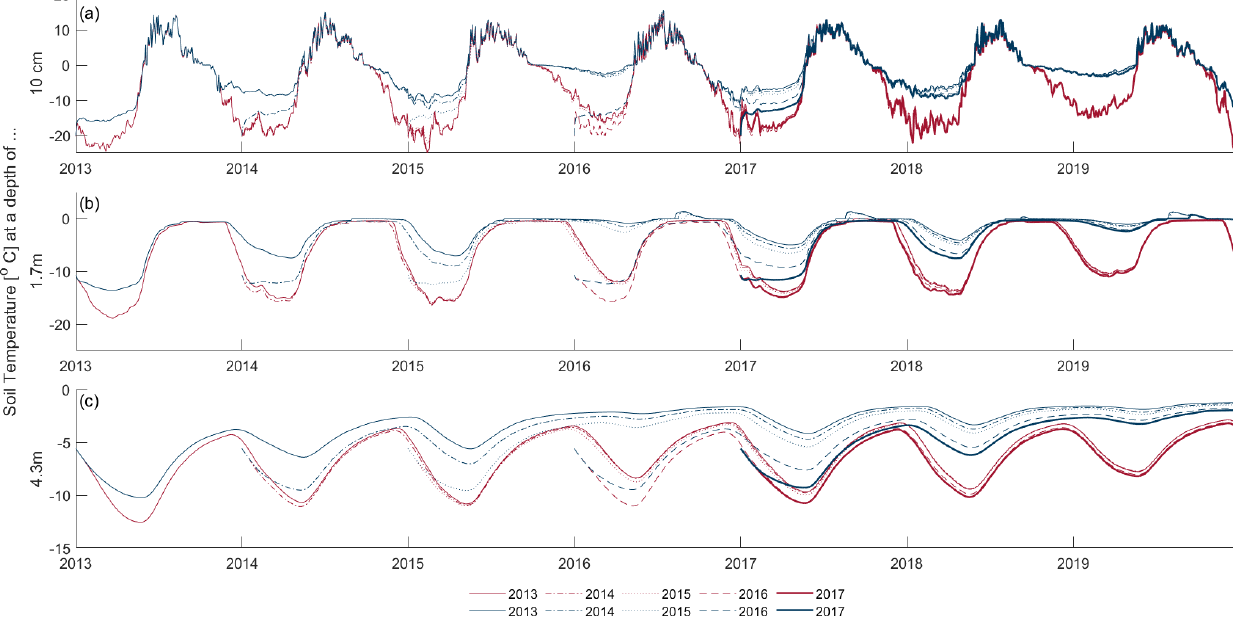
Figure B1. Soil temperatures at (a) 10cm, (b) 1.7m and (c) 4.3m (3rd, 11th and 16th CLM soil layers) for varying lengths of model spin-up (line styles; all spin-ups from 1 January, year given in legend), for both baseline ( α = 1; dark red) and K eff adjusted ( α = 0 . 3; navy blue) model